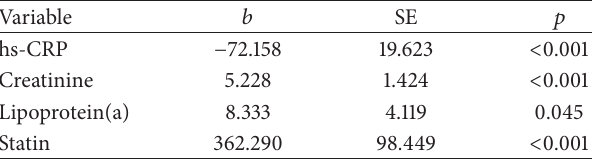
Table 4: Variables independently associated with Gensini score, as identified by multiple regression